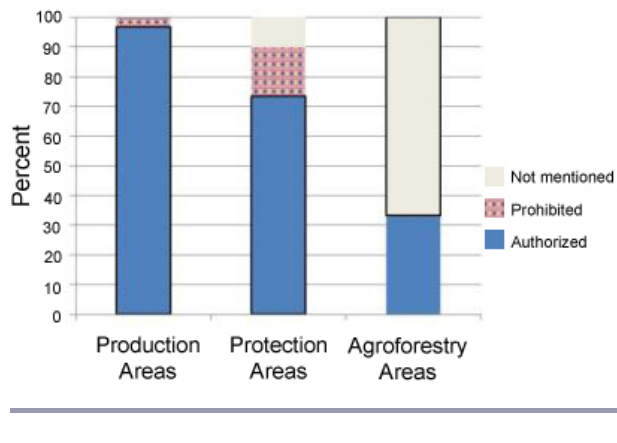
Fig. 5 . Regulation of fuelwood and timber extraction in 30 forest management plans.